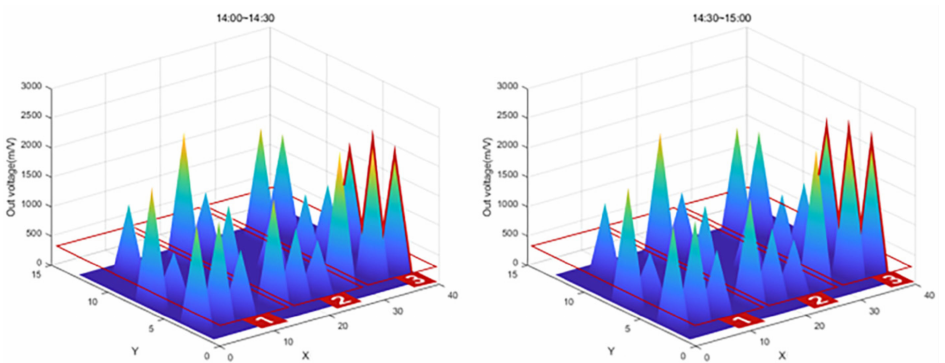
Figure 32. Sum of 3D graph values for data from